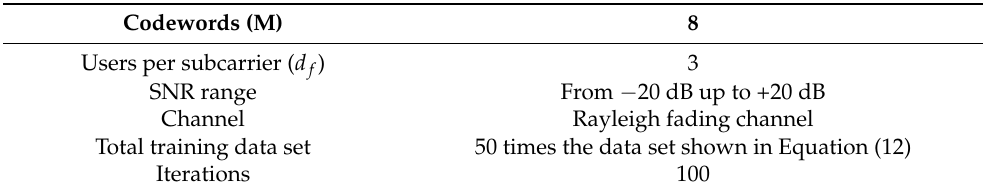
Table 2. Configuration parameters of the training stage.